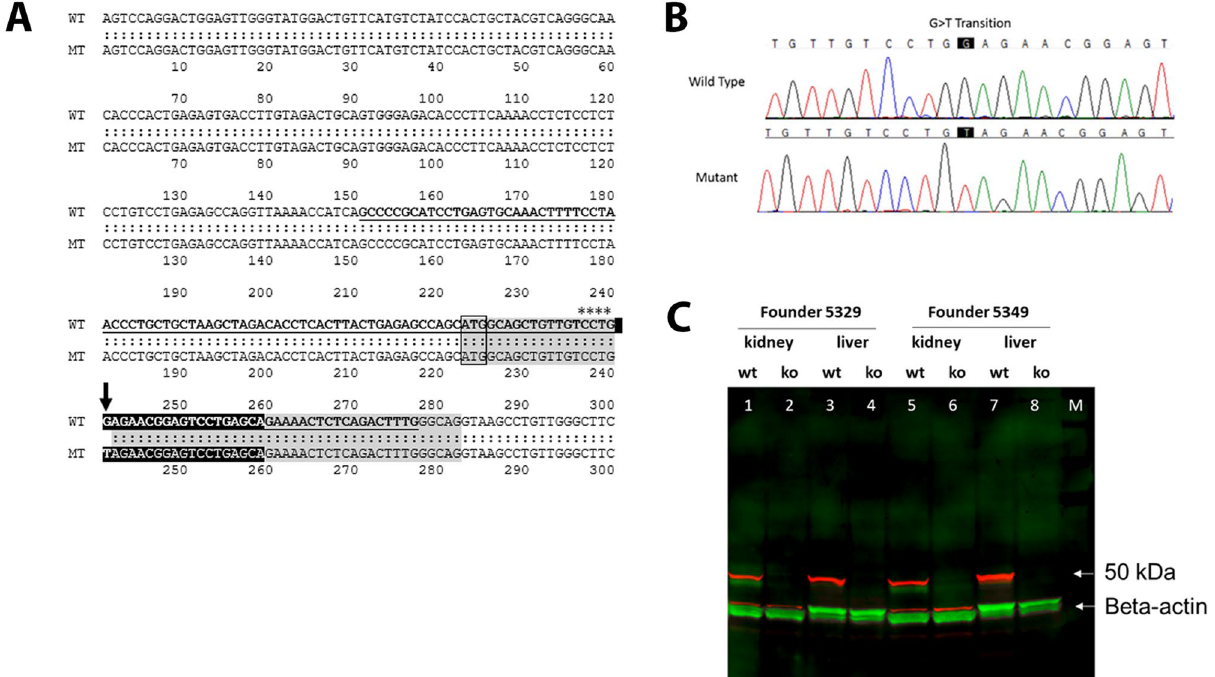
Figure 1. Creation of a Pah -KO mouse model. ( A ) The mouse genomic locus on chromosome 10 and the murine targeted allele after CRISPR gene editing are shown. Exon 1 contains the translation initiation codon. NCBI GeneID: 18478; RefSeq transcript: NM_008777. Exon 1 sequence is shadowed gray, the start codon (ATG) is framed, gRNA is shown as white letters on a black background, the asterisks and arrow indicate the position of PAM and G>T transition. The donor oligo for CRISPR targeting is in bold and underlined. ( B ) Sequencing genomic DNA samples of the founder 5349. The point mutation of G to T is indicated in the black boxes. ( C ) Western blot analyses to detect PAH protein in liver or kidney of wildtype (wt) or Hom (ko) mice. Solubilized proteins (60 µg) from mouse liver or kidney were fractionated and immune-blotted with an anti- PAH antibody. The PAH protein (red; expected size 50 kDa) is evident in wildtype mice (lanes 1, 3, 5 and 7) but is absent in Hom mice (2, 4, 6 and 8); lanes 1, 2, 5, 6) are from kidney; lanes 3, 4, 7, 8 are from liver. Equal loading is indicated by probing with antibody to beta-actin (green). M, molecular weight marker lane (bands not visible in this image).